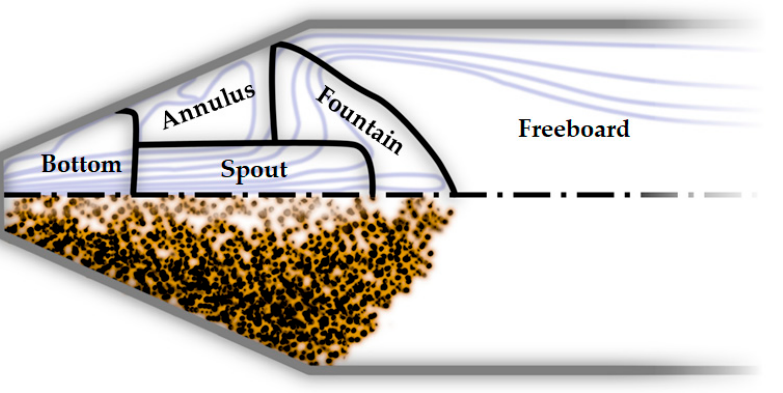
Figure 15. Schematic of the spouted bed reactor divided into five zones, based on the streamlines and flow regimes obtained by the CFD simulations to be used in the ERN model. Reprinted (adapted) with permission from [61]. Copyright 2014 American Chemical Society.